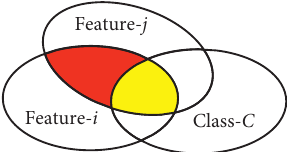
Figure 1: Venn diagram showing the relationships among feature i , feature j , and class C .